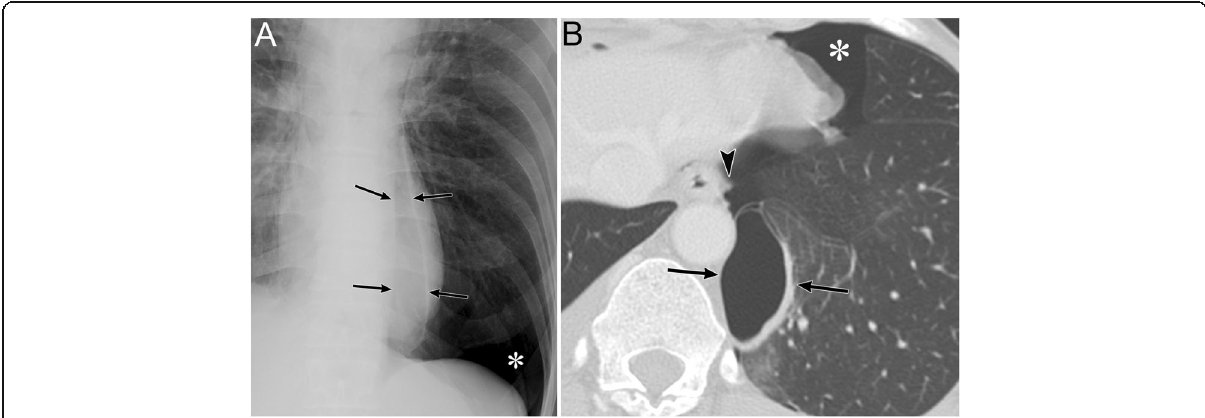
Fig. 19 A pneumatocele mimicking inferior pulmonary ligament (IPL) air collection of a 61-year-old man. He has right main bronchial stricture treated under positive pressure ventilation. a A supine radiograph shows an oval lucency (black arrows), which represents a left lower lobe pneumatocele, in the left paramediastinal area. A pneumothorax (white asterisk) is also visible, but the pneumomediastinum is not present. b An axial CT image reveals a left lower lobe pneumatocele (black arrows), while the normal left IPL (black arrowhead) lies along the esophagus. A pneumothorax (white asterisk) is also visible. The pneumatocele and pneumothorax disappeared on the supine radiograph 3 months